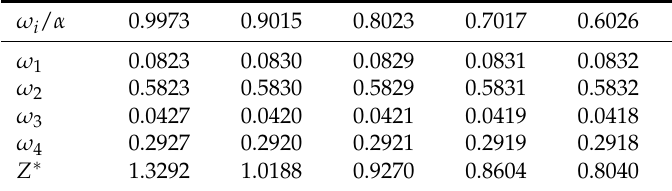
Table 1. Weights of the normally distributed preference relation (PR) N ( B